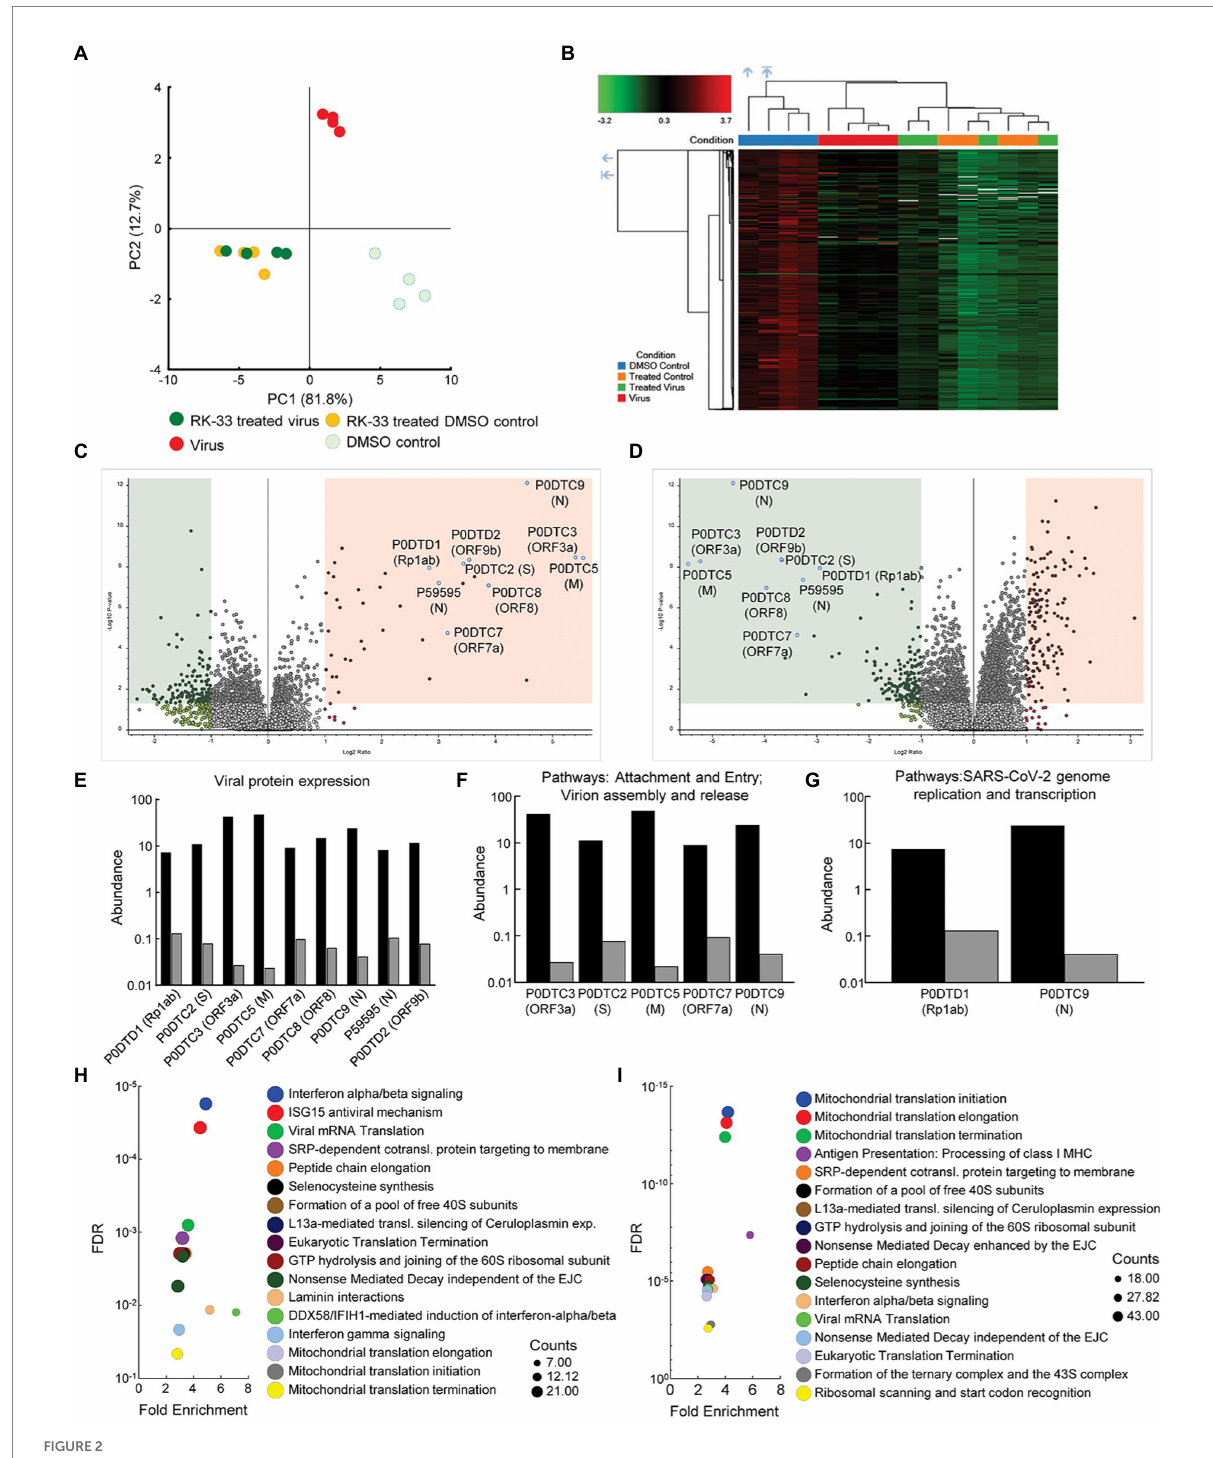
FIGURE 2 Proteomics of host and viral proteins from Calu-3 viral infected cells. (A) Protein abundances from all samples were analyzed and plotted on a PCA plot. PC1 contributes to 82% and PC2 contributes to 13% of the variation. (B) Dendrogram and heat map of proteins as estimated by Euclidean clustering and median linkage. Samples were scaled after clustering. (C) Volcano plot displaying SARS-CoV-2 proteins that were differentially regulated following virus infection of Calu-3 cells. Proteins are labeled with gene names in parentheses. Red shading includes proteins that were significantly upregulated ( p < 0.05, and 1.1-fold change). Green shading indicates proteins that were significantly downregulated (p < 0.05, and-1.1-fold change). (D) Volcano plot displaying effect of RK-33 on SARS-CoV-2 proteins in virally infected Calu-3 cells. (E) Histogram displaying quantification of viral protein abundances showing effect of RK-33 on SARS-CoV-2 proteins. (F) Histogram indicating proteins from Reactome pathways attachment and entry, and virion entry and release affected viral proteins that are downregulated by RK-33 treatment of virally infected cells. (G) Histogram of proteins from pathway SARS-CoV-2 genome replication and transcription that are downregulated by RK-33 treatment. (H) Bubble chart displaying significant (FDR < 0.05) Reactome enrichment of pathways in SARS-CoV-2 infected Calu-3 cells. (I) Reactome enrichment pathways of RK-33 treated virally infected cells displayed as a bubble